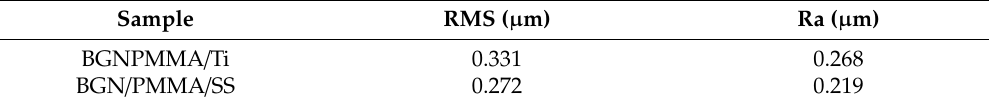
Figure 3. AFM images of films surface: ( a ) BGN / PMMA / Ti, ( b ) BGN / PMMA / SS. Figure. 3 . AFM images of films surface: ( a ) BGN/PMMA/Ti, ( b ) BGN/PMMA/SS Table 2. Roughness values of thin films before immersion in simulated body fluid (SBF).